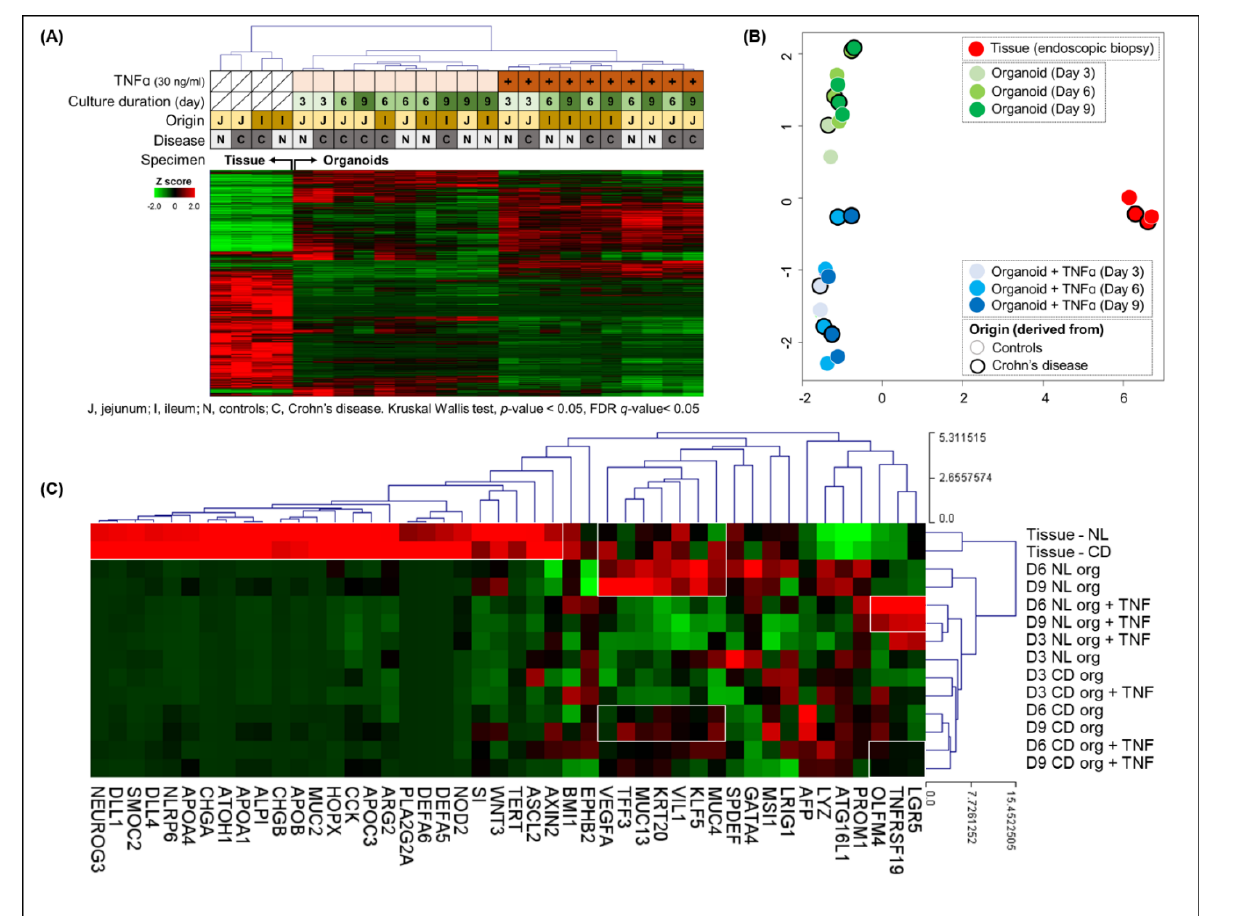
Figure 9. Gene expression profile of the endoscopic biopsy tissue samples from controls and patients with CD and organoids derived from these samples. ( A ) Clustering heatmap and ( B ) principal component analysis. The gene expression profile was clearly separated between the endoscopic biopsy tissue samples and the organoids derived from these samples. Among the gene expression profiles of organoids, a clear distinction was noticed between TNFα-free and -treated organoids. ( C ) Epithelial lineage-specific gene expression. The expression of differentiated cell markers was increased in endoscopic tissue biopsy samples. However, the expression of enterocyte markers, such as VIL1, KLF5, and KRT5, and goblet cell markers, such as TFF3 and MUC13, was increased in the biopsy tissue samples, as well as the TNFα-free organoids. In the TNFα-treated control organoids, the expression of ISC markers, such as LGR5, OLFM4, and TNFRSF19, was increased compared with those of TNFα-treated CD patient-derived organoids.